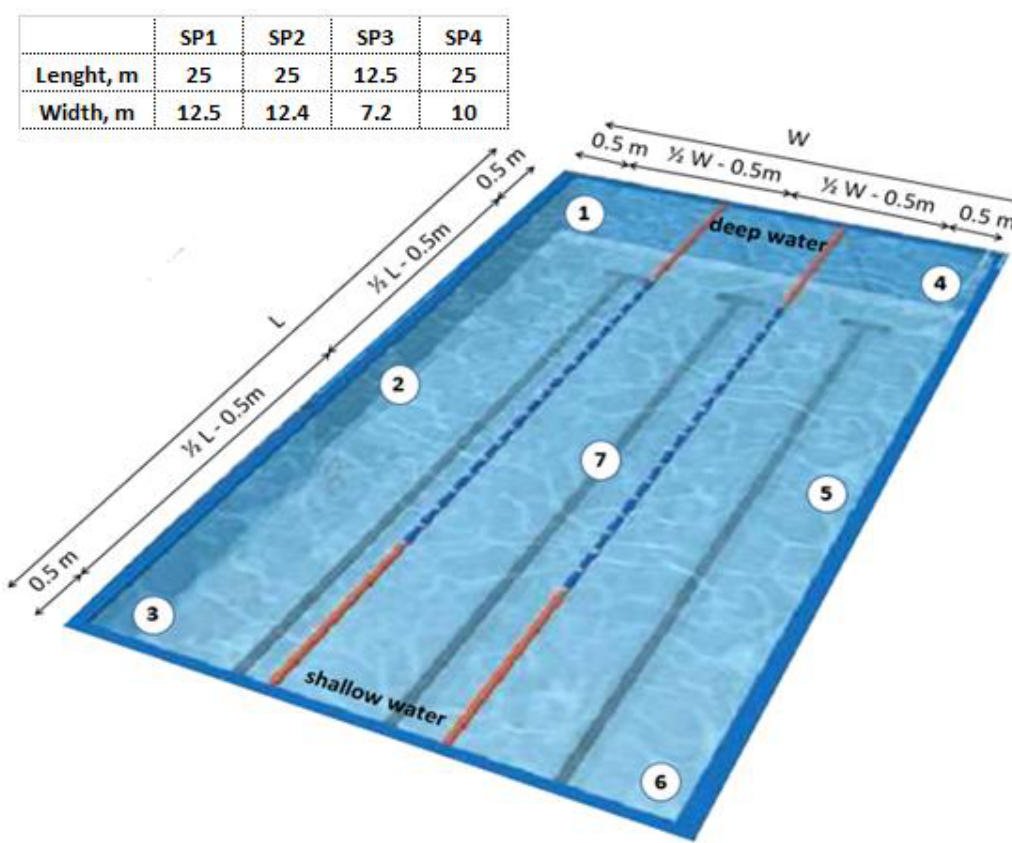
Figure 2. Location of sampling points in tested swimming pools.